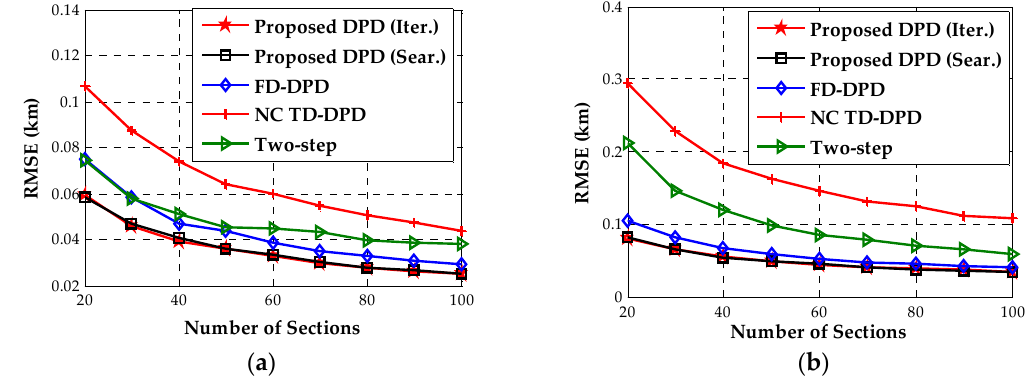
Figure 5. The estimated RMSEs versus the number of sections for near-field sources. ( a ) Source 1; ( b ) Source 2.